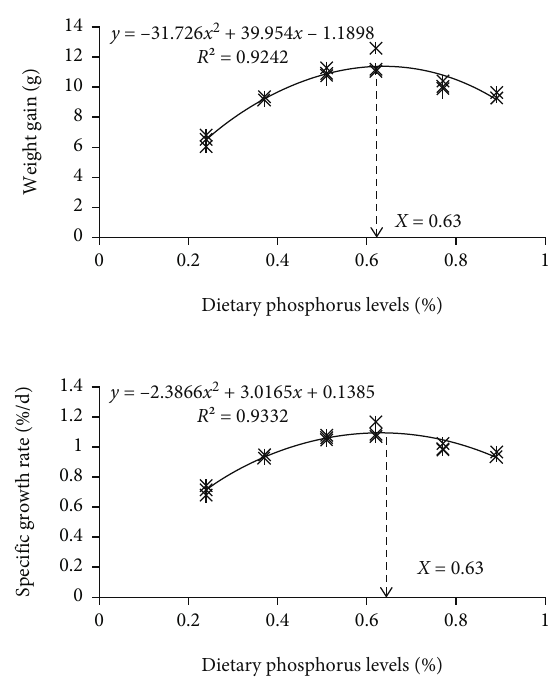
Figure 1: Quadratic regression analyses of weight gain and speci fi c growth rate ( y -axis) in sea cucumber fed diets with graded phosphorus levels ( x -axis) ( n = 3 ). The predicted dietary phosphorus level is 0.63% for maximum